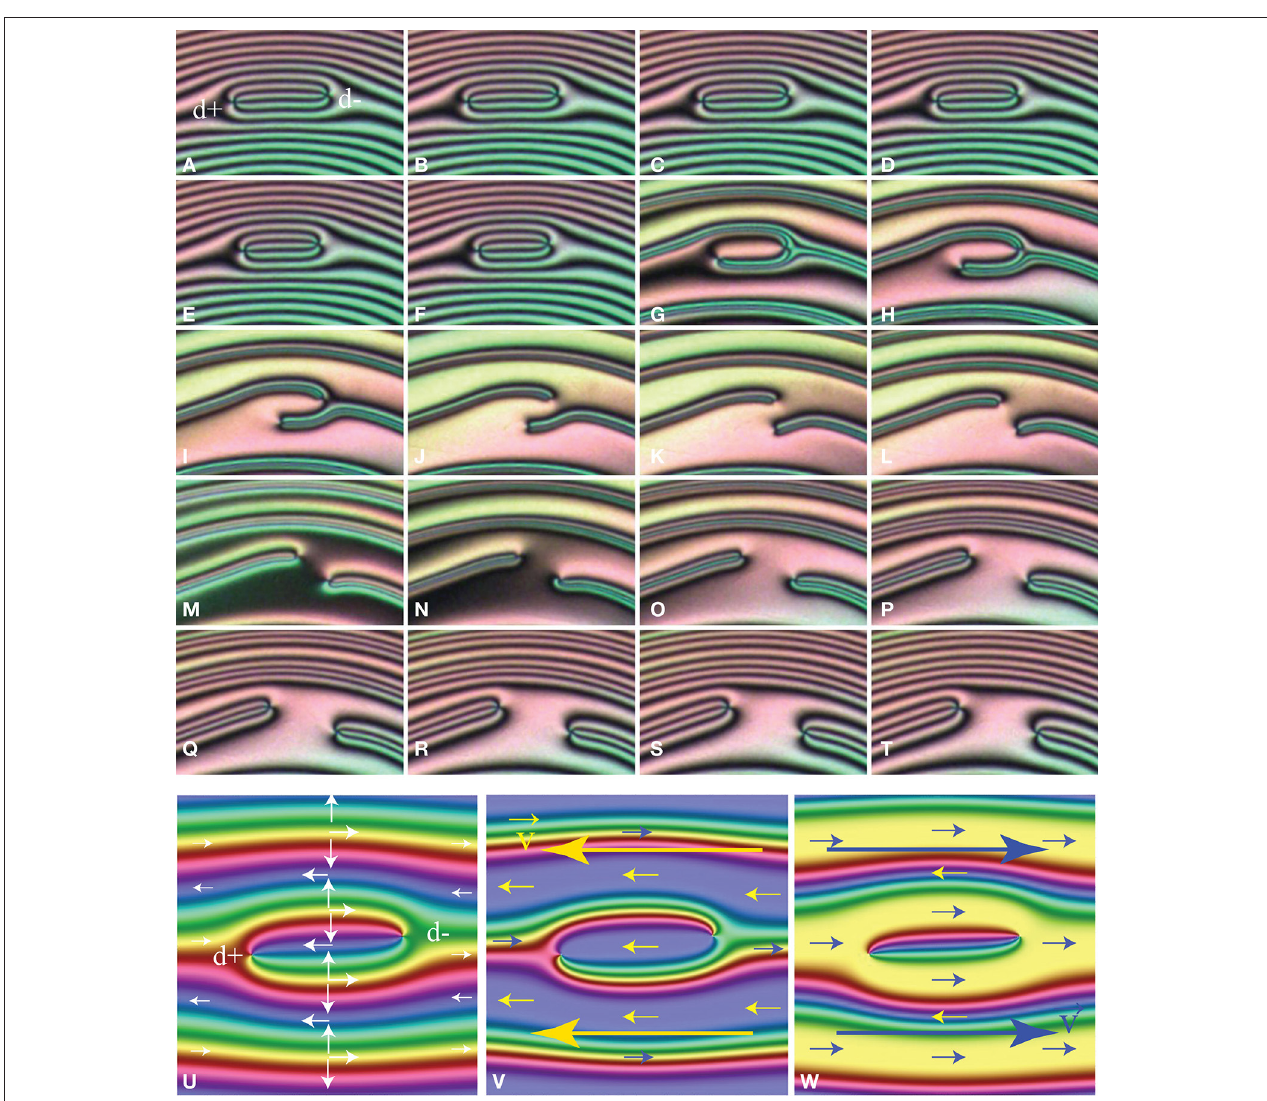
FIGURE 15 | Influence of Poiseuille flows on collisions of dowsons. (A–T) Experiment. Evolution of the dowser field before, during and after application of a Poiseuille flow. (U–W) Simulation. Pair of dowsons without flow (U) and in the presence of flows in left and right drections.